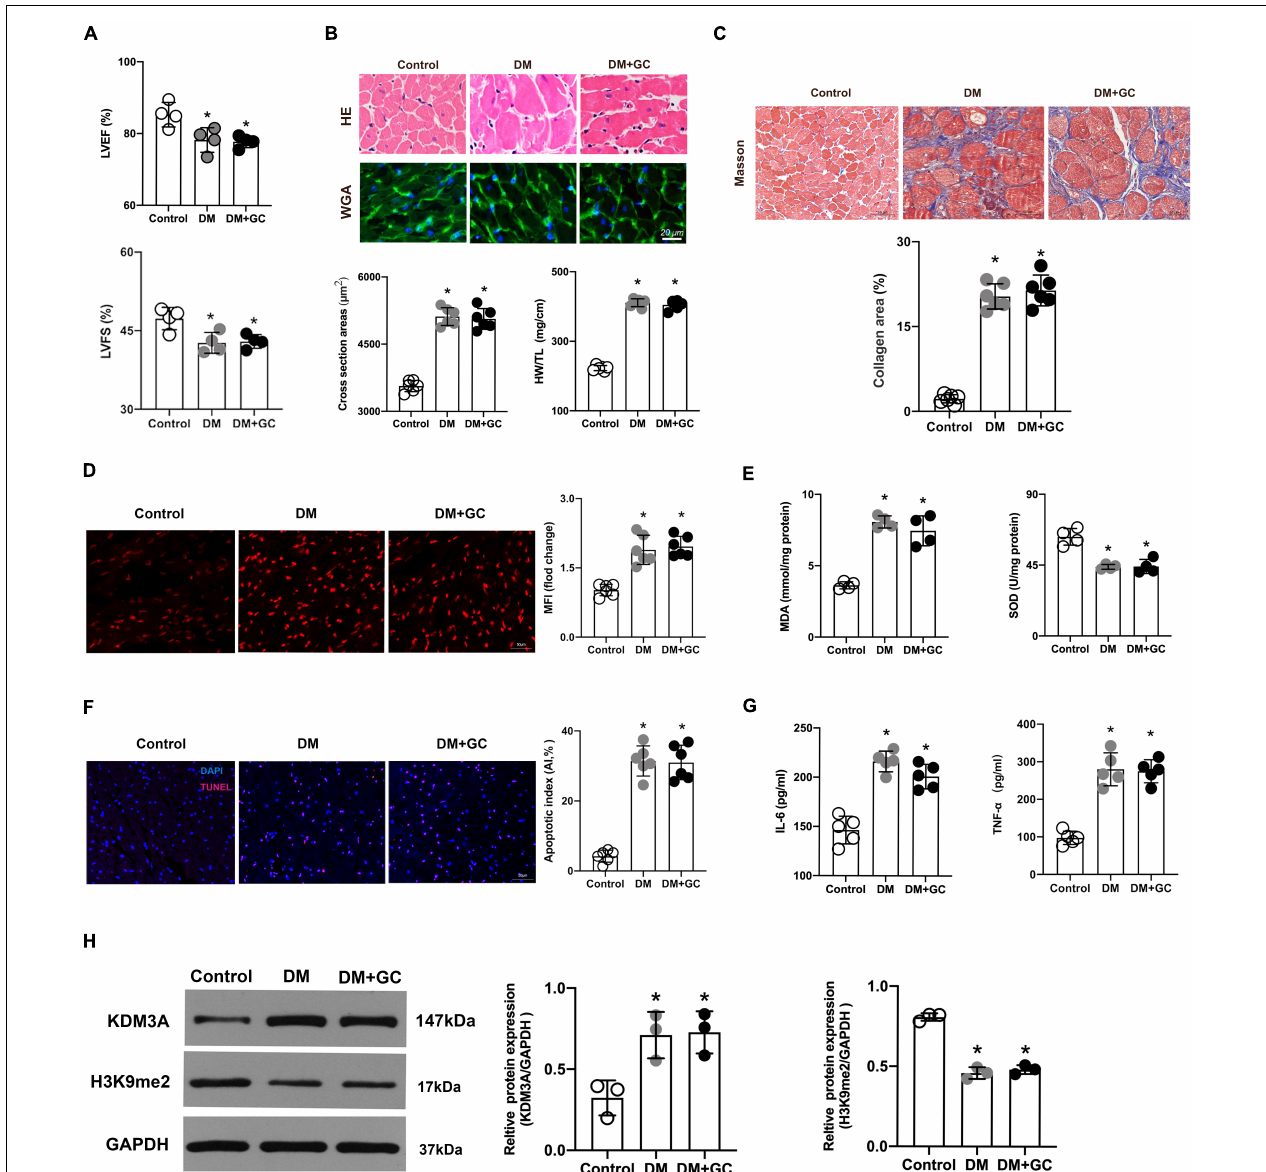
FIGURE 4 | Hyperglycemia-induced cardiac dysfunction and myocardial injury persisted even after glucose levels were normalized, accompanied by the over-expression of KDM3A. (A) The changes in cardiac function, including left ventricular ejection fraction (LVEF) and left ventricular short-axis fractional shortening (LVFS) were monitored by echocardiography in rats ( n = 4). (B) The gross view of hearts, H&E and WGA staining of myocardium were performed. The cross-sectional area of myocardial cells and the ratio of heart weight to tibial length (HW/TL) in each group were calculated to evaluate cardiac hypertrophy ( n = 5). (C) The degree of cardiac fibrosis was tested by Masson staining. The collagen area of each group was analyzed ( n = 6). (D) The ROS production in rat myocardium was detected by DHE staining and the mean fluorescence intensity were analyzed ( n = 5). (E) The MDA content and the SOD activity were tested to assess ROS generation indirectly ( n = 4). (F) The apoptosis of myocardial cells was further estimated by TUNEL staining ( n = 6). (G) The IL-6 and TNF- α content were measured using the ELISA method ( n = 5). (H) The expression of KDM3A and H3K9me2 in normal rats (control), diabetic rats (DM), and diabetic rats with glucose control by insulin (DM + GC) were also measured by western blot ( n = 3). * p < 0.05, as compared to the control